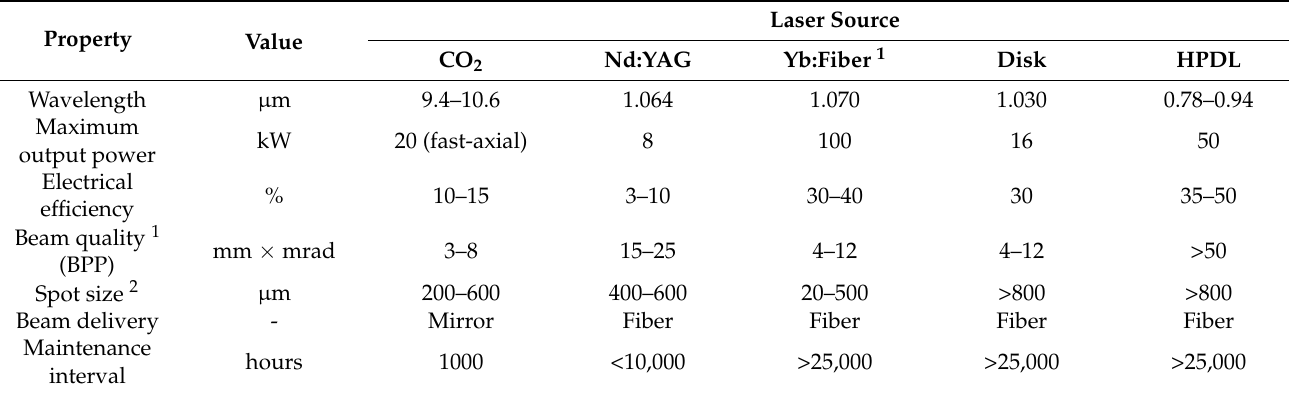
Table 3. Properties of laser sources used in laser beam welding of aluminium alloys [40,41].